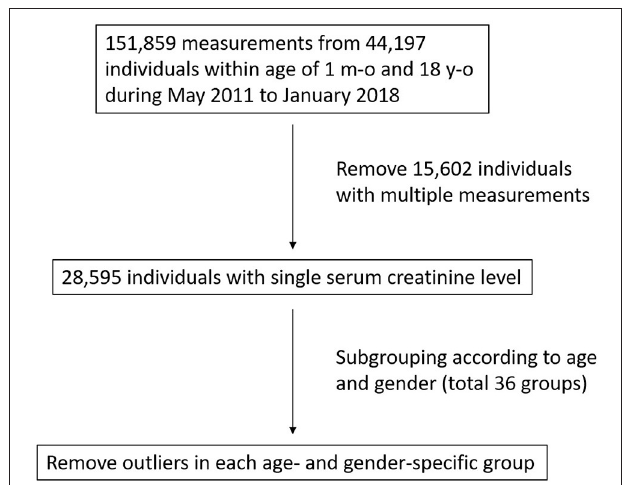
FIGURE 1 | Study population enrollment